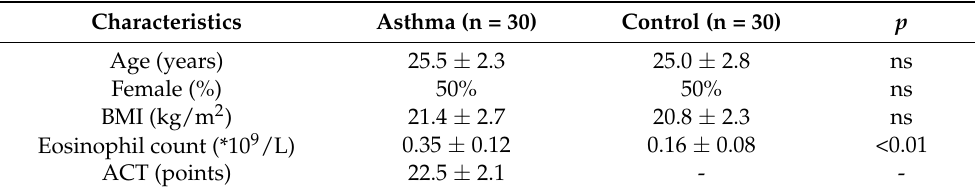
Figure 1. Cohort enrollment. Table 1. Clinical characteristics of the patients with asthma and control.